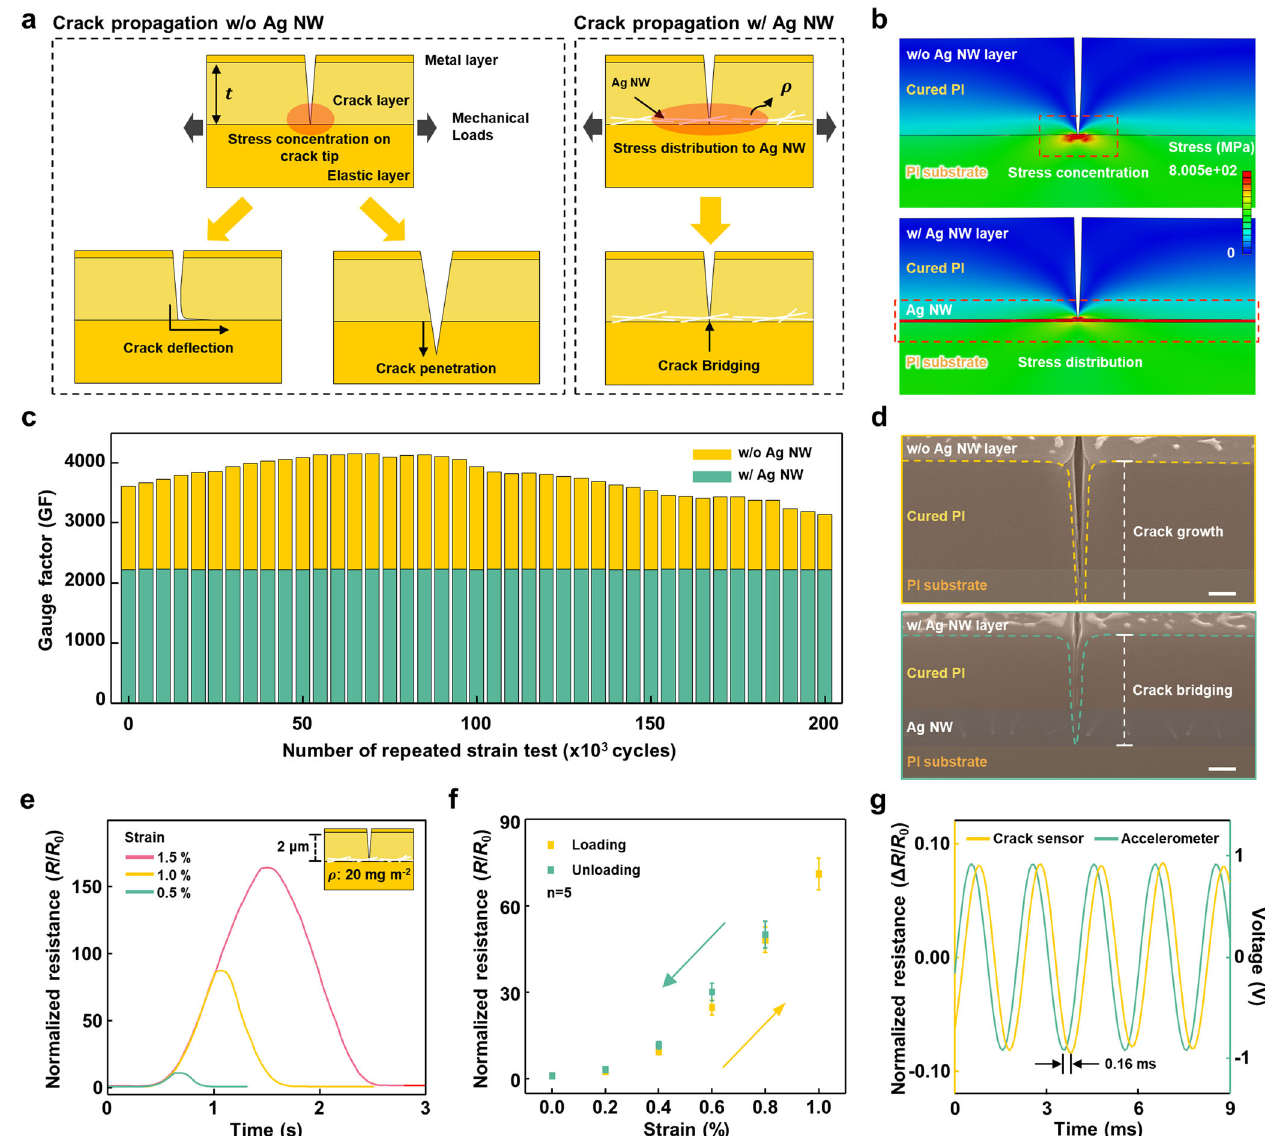
Fig. 2 Fatigue behavior under crack propagation and characteristics of sensors with and without an Ag NW layer. a Schematic illustrations of possible crack propagation scenarios in a crack-based sensor in a plane strain state. b Finite-element method modeling of crack interface deformation with and without an Ag NW layer. c Durability test results (200,000 cycles at 0.5% strain) of the crack-based sensors with and without an Ag NW layer. d Cross-sectional SEM images of the crack-based sensors with and without an Ag NW layer (Scale bar: 500 nm). e Loading-unloading sensor behavior under various fi nal strain conditions. f Loading-unloading behavior of fi ve different samples to test sensor reproducibility and hysteresis. g Response time of the sensor ’ s resistance to 1 G 500 Hz